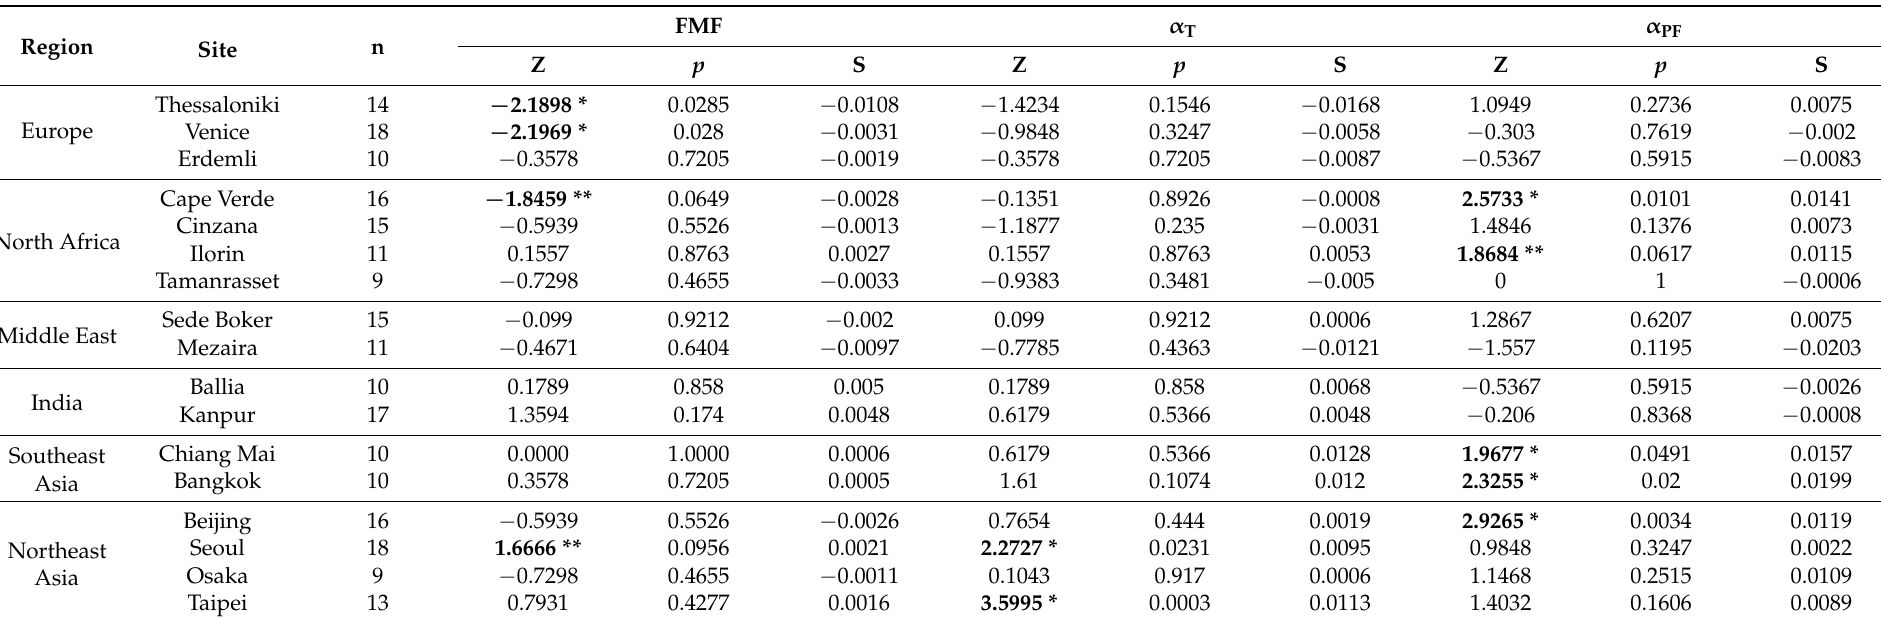
Table 4. MK-test results in terms of number of data points (m), Z value, p -value, and Sen’s slope (S) of FMF, α T and α PF . Meaning of parameters same as in Table 4.